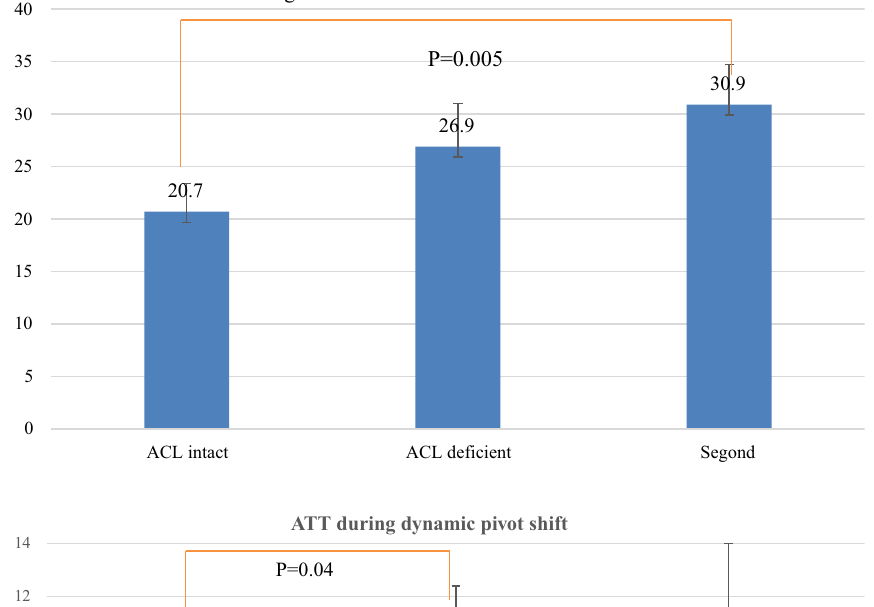
Fig. 4 Anterior tibial translation during pivot-shift (dynamic